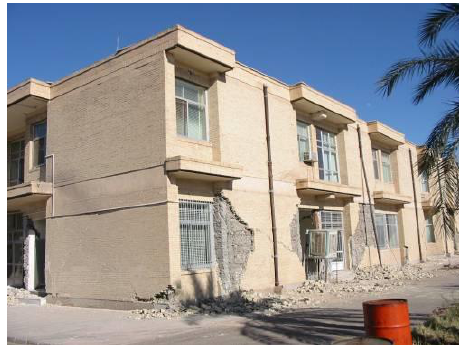
Figure 1. Control house of Bam power Substation after earthquake